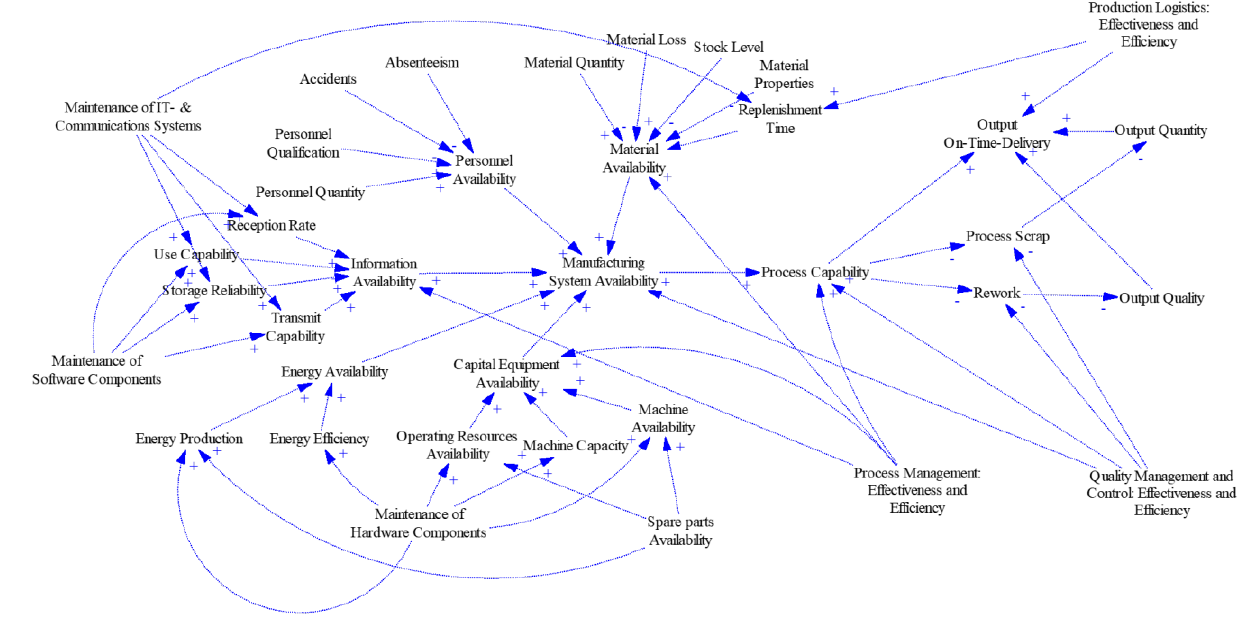
Figure 2. Casual-loop diagram (CLD) for the manufacturing process factors.